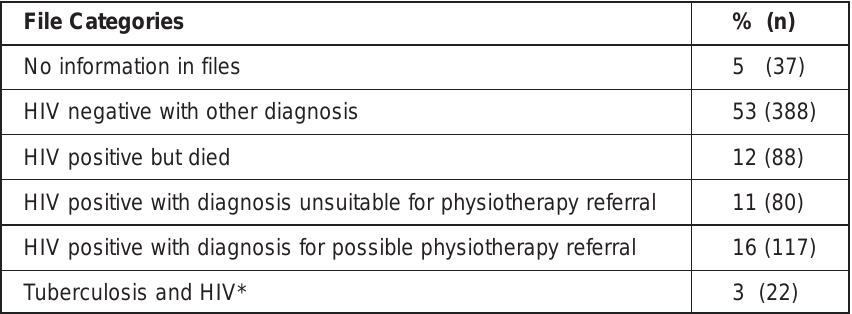
Table 1: Illustration of distribution of files according to categories (n=732).